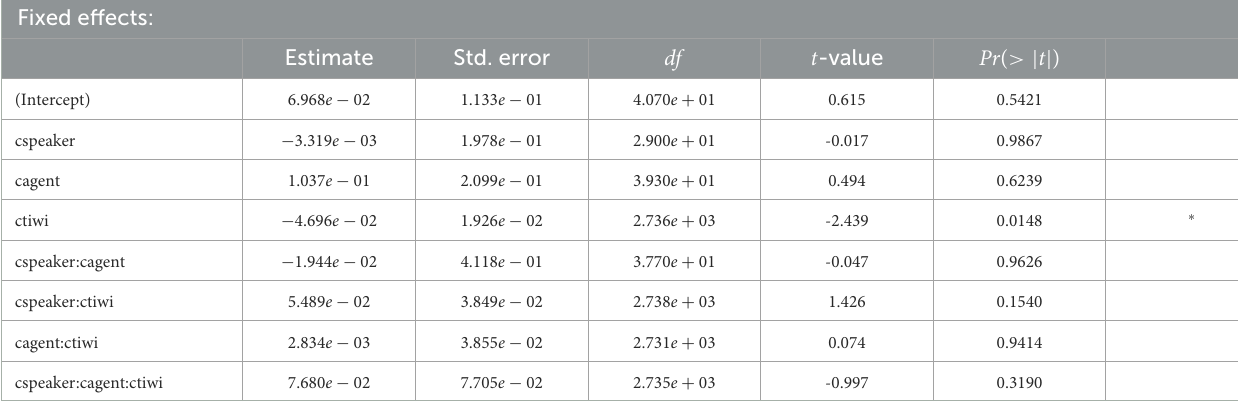
TABLE 1 Coefficients, SE s, df s, t -values, and p -values for the optimal model of log ratios of target fixations for the shift time window in Experiment 1.